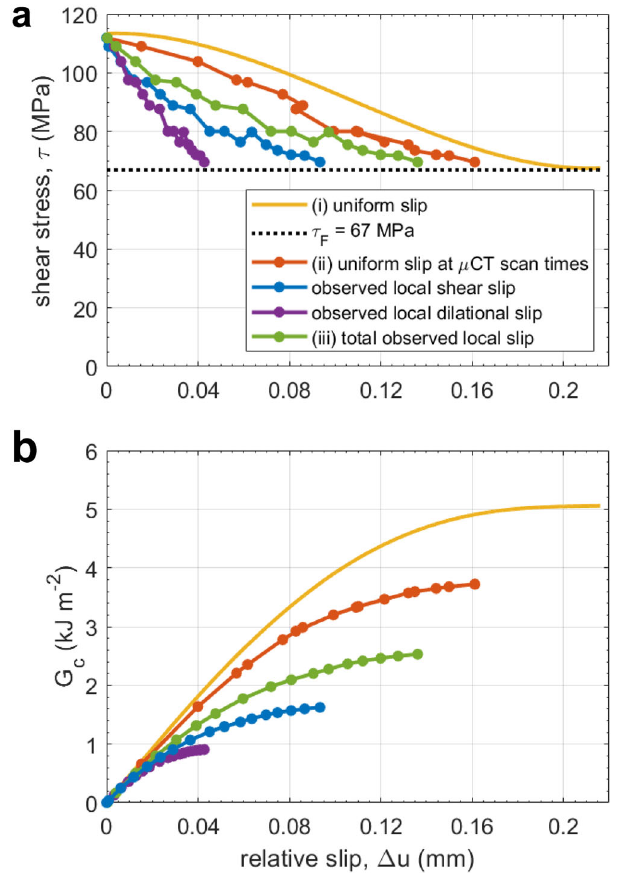
Fig. 6 | Shear fracture energy estimated from bulk strain and from local incremental strain in the shear zone. a Relationship between the shear stress acting on theshearzone, τ andrelativeslip, Δ u foraverageangle θ = 30.3° thatthe shear zone makes with the axial differential stress, σ 1 (see also Supplementary Table 1). We show relationships for (i) uniform slip, estimated according the method described in Wong et al. 28 (see also Fig. 1. in Wong et al. 28 ), from average bulk axial stress and strain data (yellow), (ii) uniform slip, again estimated as per Wong et al. 28 , from actual bulk axial stress and strain measurements at each μ CT scan time (orange) and (iii) total observed local slip in the developing shear zone (green), obtained from direct dilation and shear strain measurements (see Meth- ods).Weobtainedtheshearfractureenergy, G c byintegrationunderthe τ - Δ u curve frompeakshearstress, τ P totheresidualfrictionalstrength τ F (dottedblackline)of the shearzone. At τ F , the shearzone reached the critical slipdistance, Δ u *atwhich breakdown transitions to frictional sliding. The contributions to (iii) from local shear strain (blue) and local dilation (purple) are also shown. b Evolution of G c , calculated from a , as Δ u